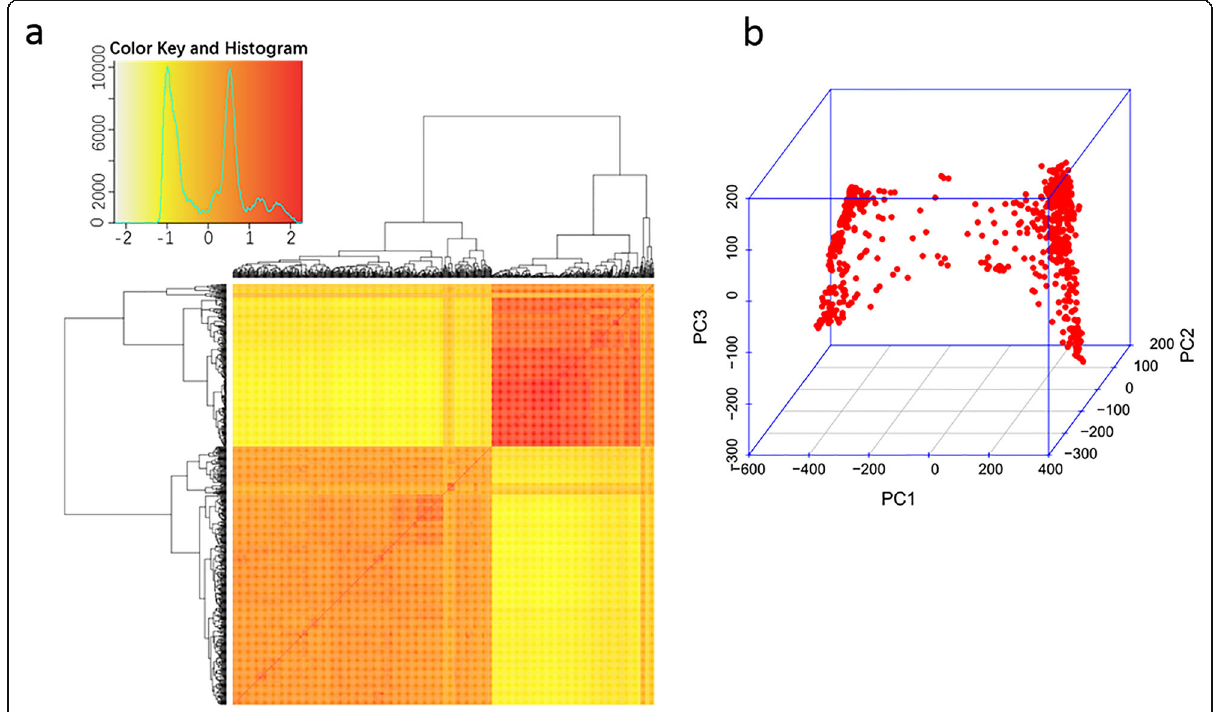
Fig. 2 Population structure of the rice germplasm association panel revealed by kinship (a) and principle component analysis (PCA) (b)